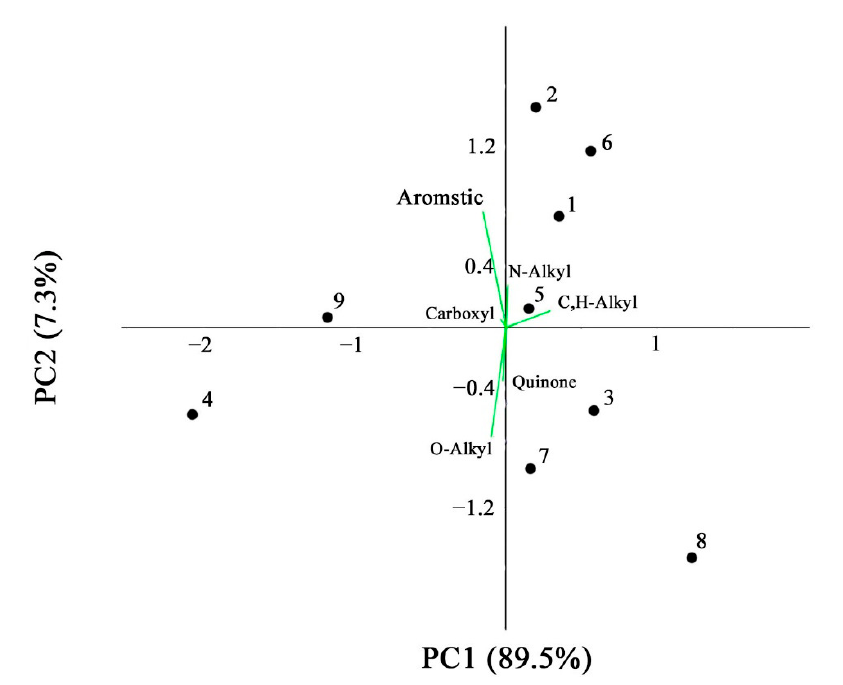
Figure 7. Representation of the samples of humic acids in the plane defined by the first two axes obtained by principal component analysis (96% of the total variance explained).